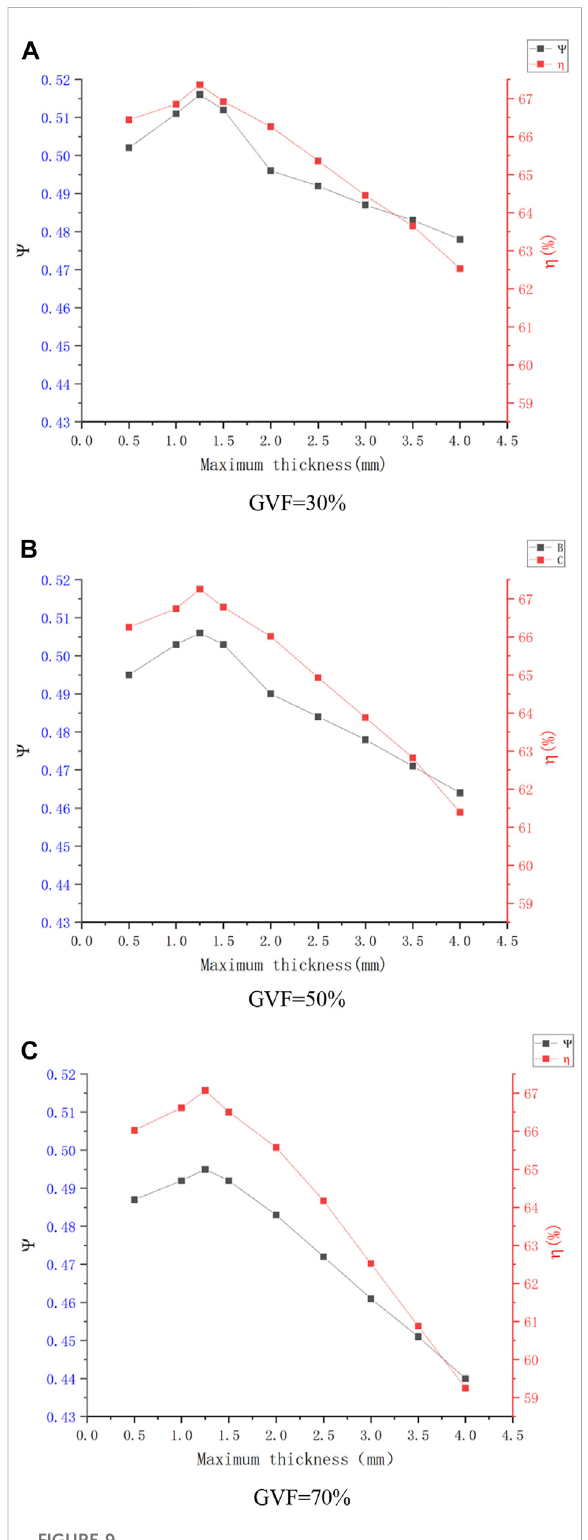
FIGURE 9 Variation curve of the external characteristics after modi fi cation. (A) GVF = 30%. (B) GVF = 50%. (C) GVF = 70%.